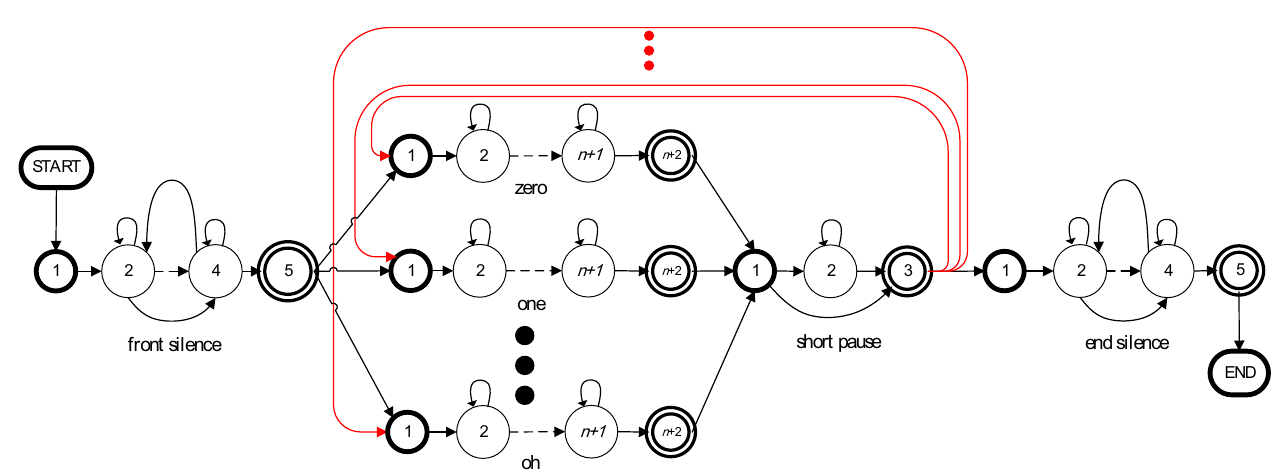
Fig 12. Detailed network of our connected-digit recognition